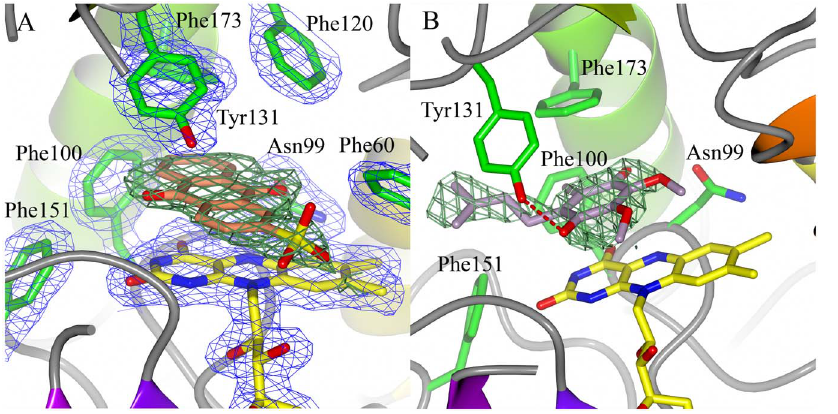
Figure 4. Binding of paAzoR1 to AQN and UQ1. Binding of paAzoR1 to AQN (A) and UQ1 (B). AQN is shown with pink carbon atoms, UQ1 with grey carbon atoms and FMN with yellow carbon atoms. The green mesh is unbiased positive difference density ( F o - F c map) contoured at 3 s while the blue mesh is the refined 2 F o - F c map at 1 s . A red dashed line signifies a hydrogen bond. Residues interacting with the ligands are labelled. (A) is based upon PDB 4N65, while (B) is based upon PDB